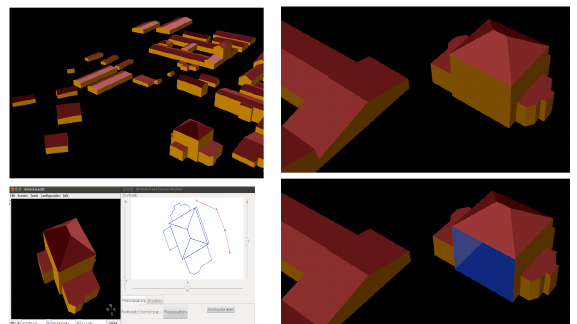
Figure 3: Octomap generated based on the 3D model provided by the mission planing system. ( c (cid:13) Matthias